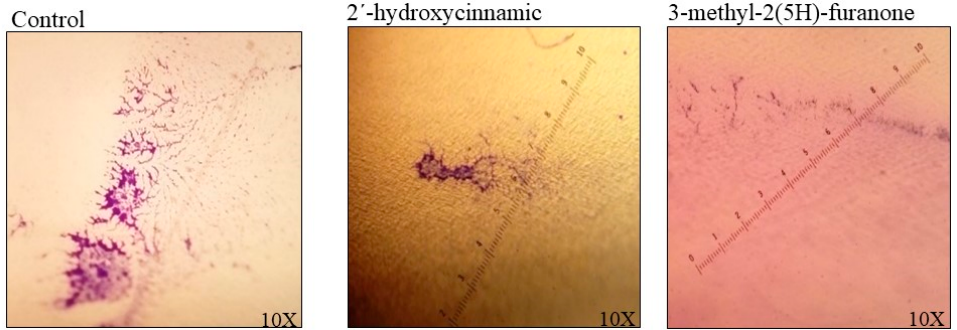
Figure 7. The appearance of the biofilm of K. pneumoniae in a polyvinyl chloride (PVC) urethral catheter. Biofilm formed at 30 h of incubation at 37 °C was stained with violet crystal at 0.05%. The size of